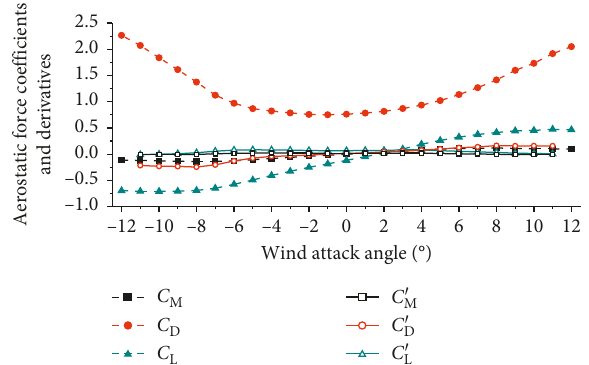
Figure 3: Aerostatic force coefficients and their derivatives.